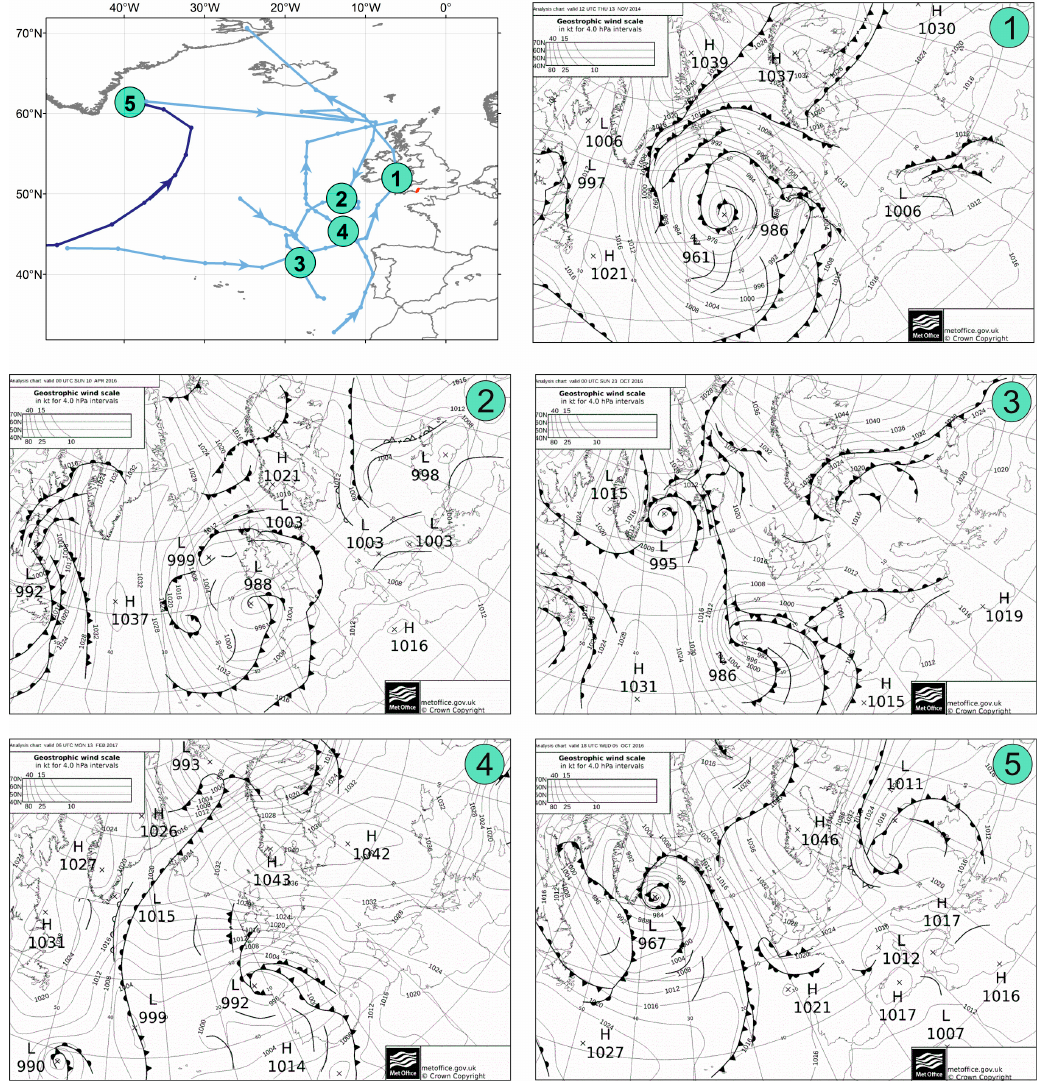
Figure 8. Tracks of storms affecting only West Lyme Bay. The associated pressure charts show the situation around the time when the highest waves were generated.